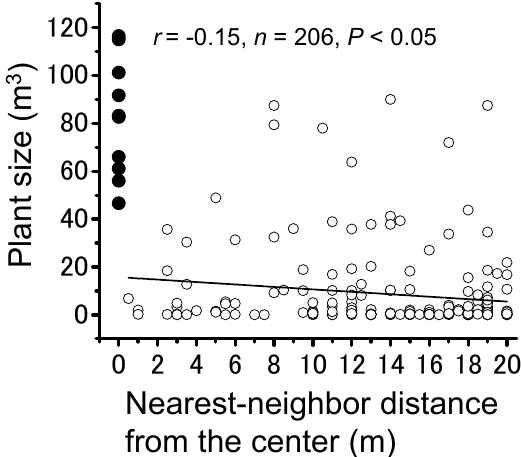
(10 m; Pearson’s correlation; r = 0.34, n = 11, p < 0.001). These results suggested that the trees roosted on by the largest locust group were conspicuous within the local plant community.